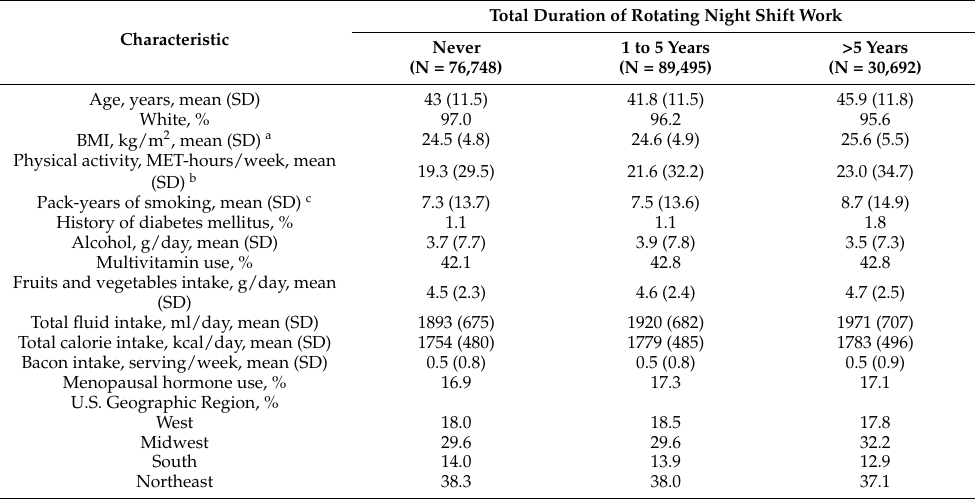
Table 1. Age and age-adjusted characteristics of 196,935 study participants according to their total duration of rotating night shift work in the pooled Nurses’ Health Study (baseline in 1988, n = 82,147) and Nurses’ Health Study II (baseline in 1989, n = 114,788). Total Duration of Rotating Night Shift Work Characteristic Never 1 to 5 Years >5 Years (N = 76,748) (N = 89,495) (N = 30,692) Age, years, mean (SD) 43 (11.5) 41.8 (11.5) 45.9 (11.8) White, % 97.0 96.2 24.6 (4.9) 25.6 (5.5) Physical activity, MET-hours/week, mean